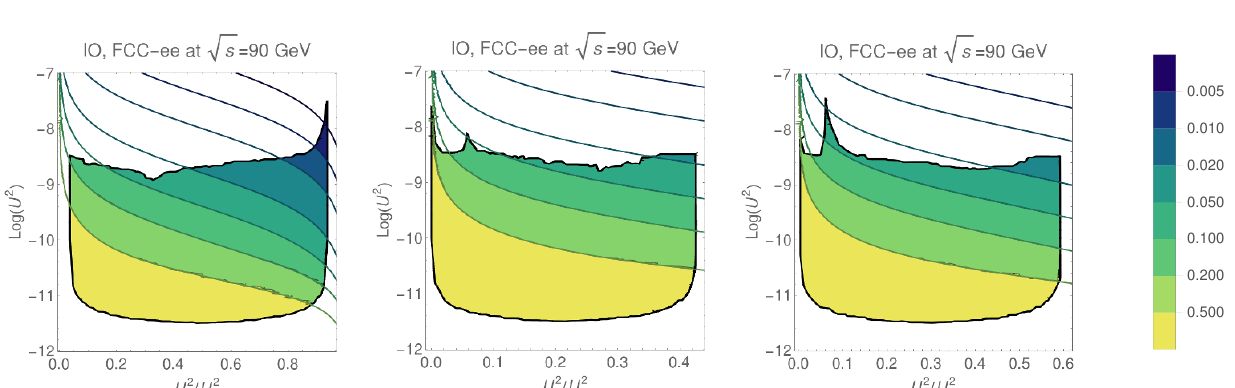
Figure 7 . The colour indicates the precision that can be achieved for measuring U 2 both normal ordering (NO) and inverse ordering (IO) of the light neutrino masses. Leptogenesis is viable in the regions with solid colour. The two heavy neutrinos are assumed to be almost degenerate in mass at M = 30 GeV. Details are given in the main text, cf. section